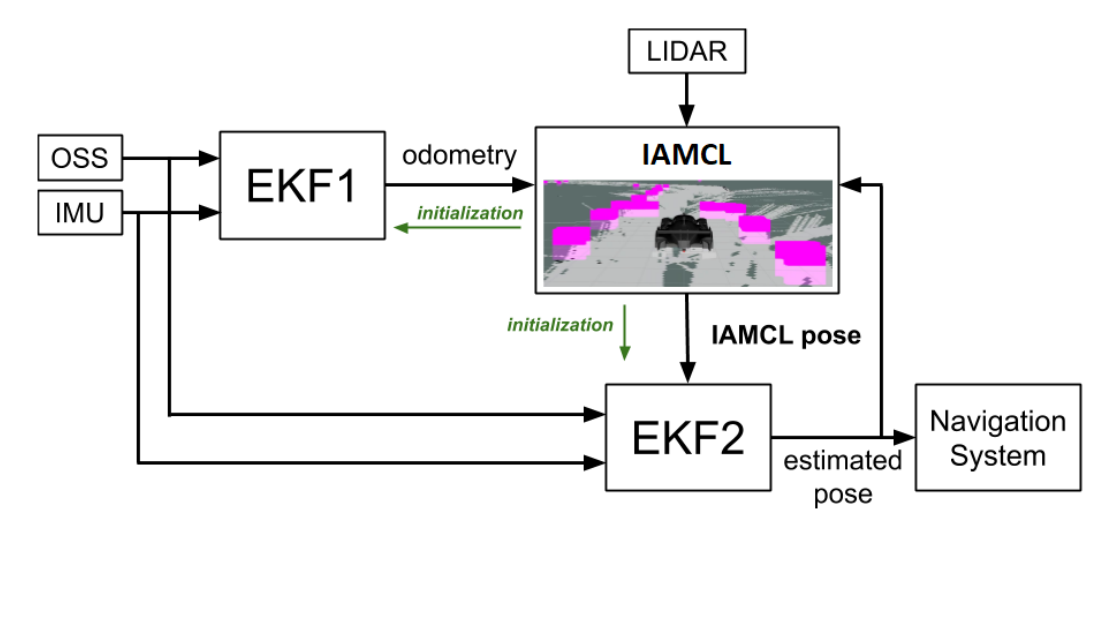
Figure 6. Localization pipeline overview. OSS and IMU data feed the Extended Kalman Filters (EKFs); EKF1 produces an odometry estimate which is sent to the Informed Adaptive Monte Carlo Localization (IAMCL) module. By comparing LiDAR data with the pre-built map, IAMCL outputs a pose estimate that is then sent to EKF2, a smoothing filter with a high-frequency output. The green arrows indicate the initialization procedure described in Section